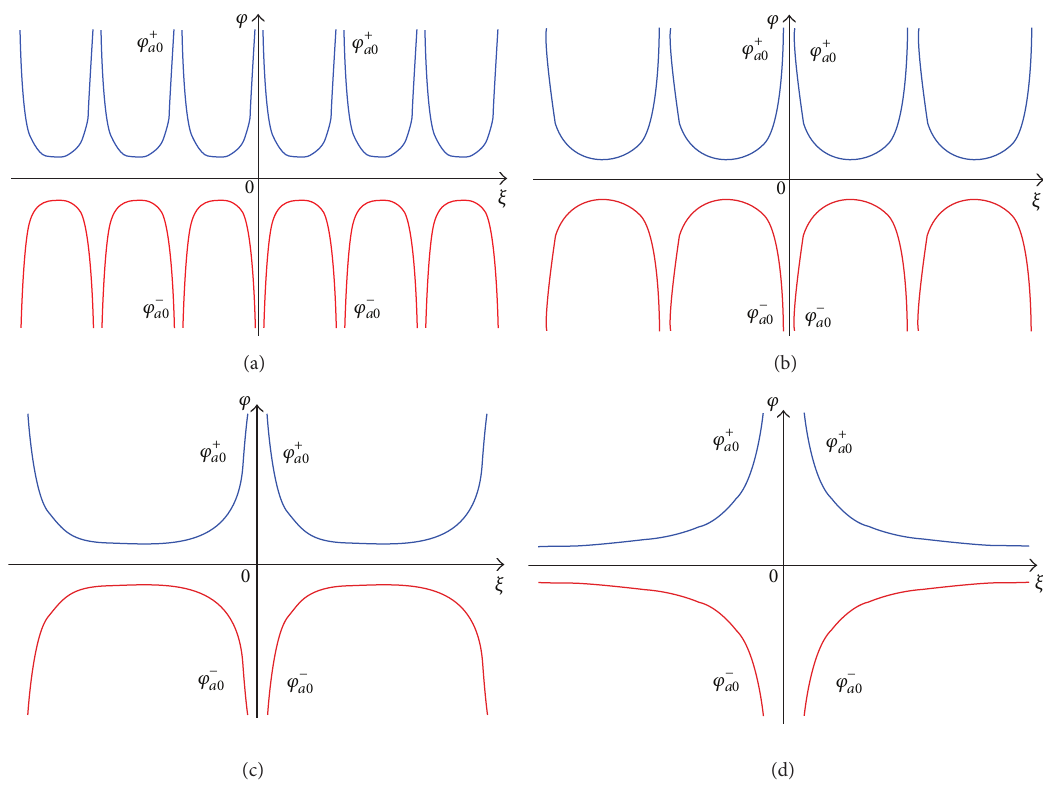
Figure 2: (The 1-blow-up waves are bifurcated from the periodic-blow-up waves.) The varying process for the figures of 𝜑 ± 𝑎0 when (𝑞,𝑝) ∈ 𝐴 1 and 𝑝 → 0 − 0 , where 𝑟 = 1 , 𝑞 = 4 and (a) 𝑝 = 0 − 10 −1 , (b) 𝑝 = 0 − 10 −2 , (c) 𝑝 = 0 − 10 −3 , and (d) 𝑝 = 0 − 10 −4 . (1) For the case of 𝜆 > 0 , there are four properties